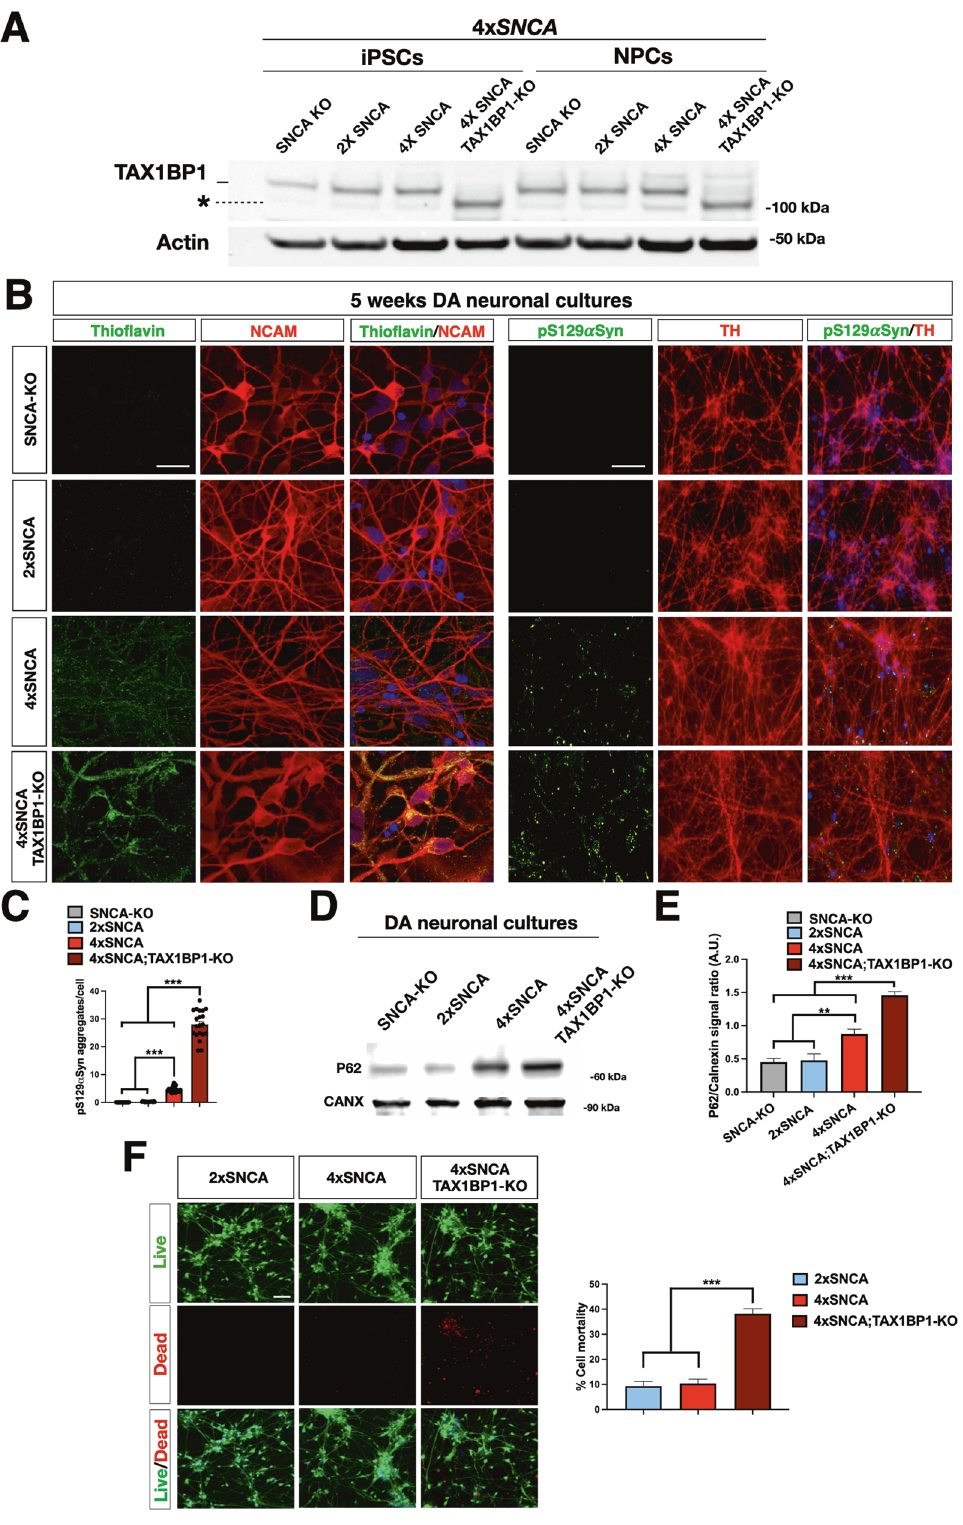
Fig. 7 TAXBP1 inactivation exacerbates α Syn aggregates in DA neurons. A Immunoblot analysis for the TAX1BP1 protein con fi rms the inactivation of the gene in 4x SNCA ;TAXBP1-KO iPSCs. * indicates a non-speci fi c signal. B Representative images of 4x SNCA ;TAXBP1-KO stained with Thio fl avin S and pS129 α Syn. C Quanti fi cation of the number of pS129 α Syn + aggregates in SNCA-KO, 2x, 4x SNCA , and 4x SNCA ;TAXBP1-KO DA neurons. Dots represent quanti fi cations in fi ve fi elds for four independent experiments. D , E Immunoblot and quanti fi cation of p62 signal in SNCA-KO, 2x, 4x SNCA , and 4x SNCA ;TAXBP1-KO DA neurons ( n = 3 independent experiments). F Live/dead fl uorescence staining and quanti fi cation of cell viability and toxicity 2x, 4x SNCA , and 4x SNCA ;TAXBP1-KO DA neurons. Values are mean ± SEM of n = 3 independent experiments ( n = 50 fi elds for each group, automatic counts). ** p < 0.01, *** p < 0.001. Statistical analysis is performed using one-way ANOVA followed by Tukey post-test. Scale bars, 100 µm. Cell Death and Disease (2022)